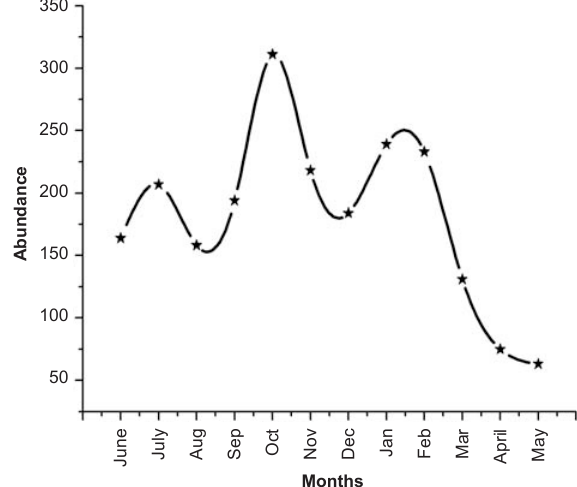
Figure 1. Abundance profile for butterflies observed in different months